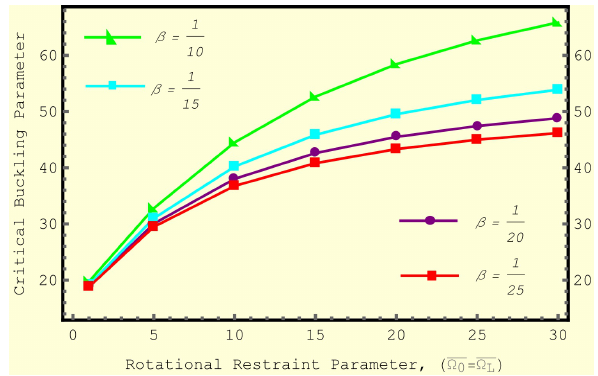
Figure 4: Effects of elastic springs on the critical buckling loads for different small scale parameter with K = 50